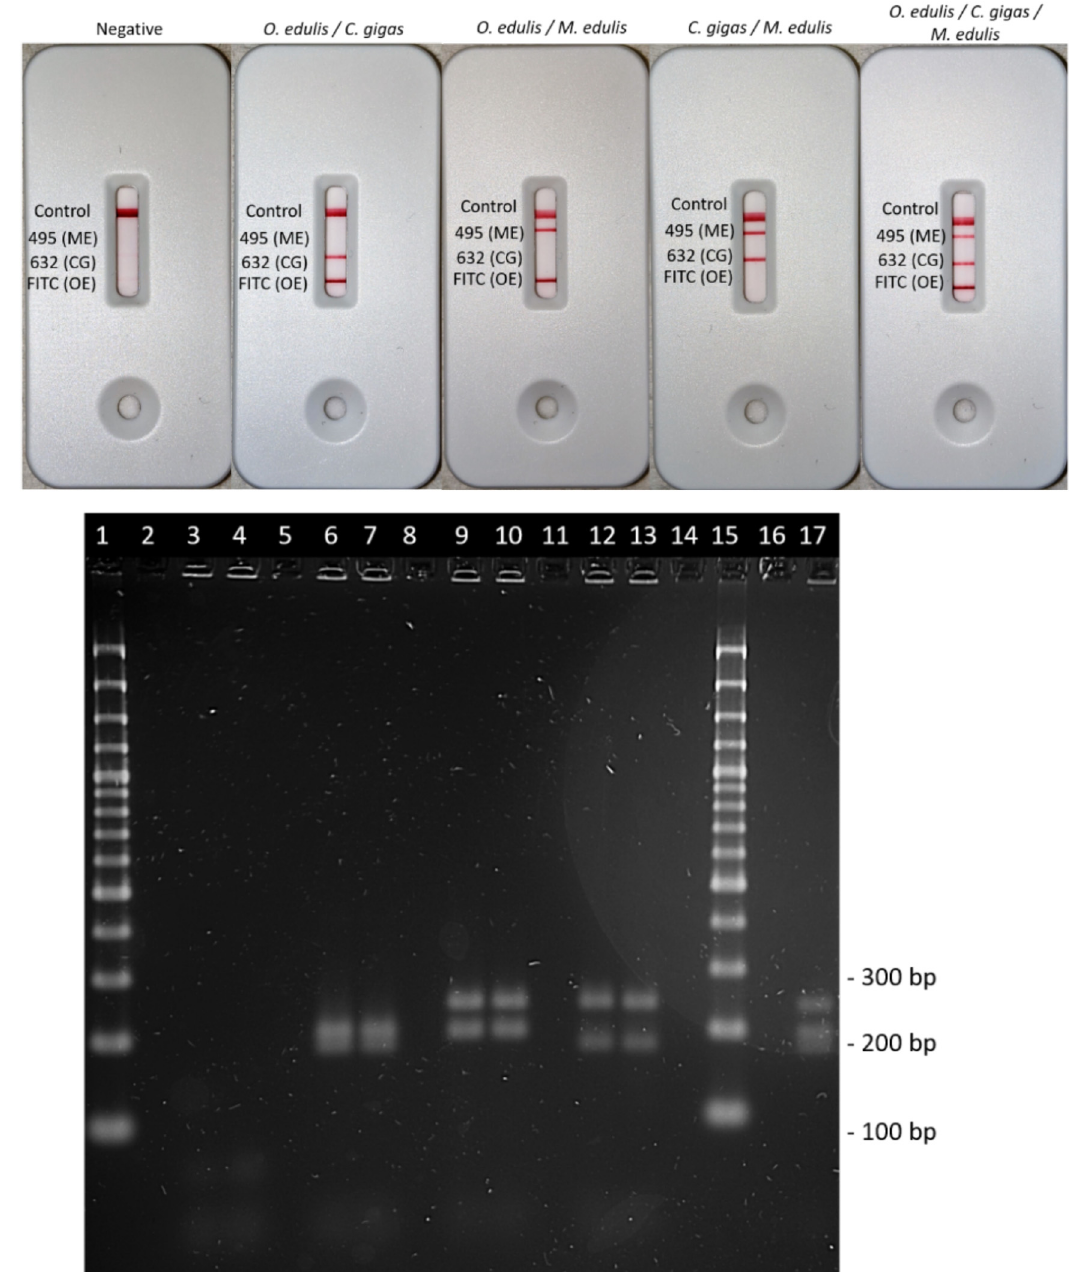
Fig. 5. PCR-nucleic acid lateral fl ow immunoassay (NALFIA) with a combination of three primer pairs and two, respectively three, DNA template of Ostrea edulis , Crassostrea gigas, and Mytilus edulis . The label on the left side of every pair of cartridges is indicating the test line for the existence of O. edulis (FITC OE), C. gigas (632 CG), and M. edulis (495 ME). The most upper line on the cartridges is indicating the control line of each NALFIA. The combinations for DNA templates are O. edulis / C. gigas, O. edulis / M. edulis, C. gigas / M. edulis , with triple primer combination of OE / CG / ME primer pairs. OE and CG primer total concentration is 10 pmol m l (cid:2) 1 , and the total ME primer concentration is 50 pmol m l (cid:2) 1 . The cartridge on the far-left side shows the non-template control of the multiplex primer combination. Other cartridges are indicating the respective combination of the DNA template above. The image of the 3% agarose gel electrophoresis is showing the quality control of the NALFIA. The scheme of the gel slots: 1: 100 bp marker, 2: empty, 3: OE / CG / ME x non-template replicate 1, 4: OE / CG / ME x non-template replicate 2, 5: empty, 6: OE / CG / ME x O. edulis / C. gigas replicate 1, 7: OE / CG / ME x O. edulis / C. gigas replicate 2, 8: empty, 9: OE / CG / ME x O. edulis / M. edulis replicate 1, 10: OE / CG / ME x O. edulis / M. edulis replicate 2, 11: empty, 12: OE / CG / ME x C. gigas / M. edulis replicate 1, 13: OE / CG / ME x C. gigas / M. edulis replicate 2, 14: empty, 15: 100 bp marker, 16: empty, 17: OE / CG / ME x O. edulis / C. gigas / M. edulis